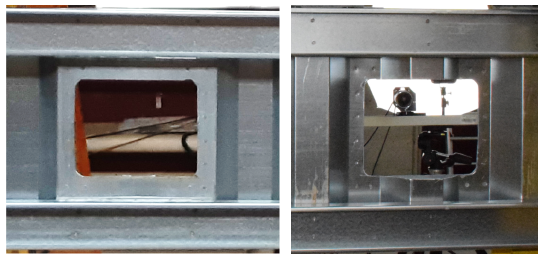
Figure 4. Reinforcing the web opening for the CWB-SW-WQ specimen assembled by spot welding.